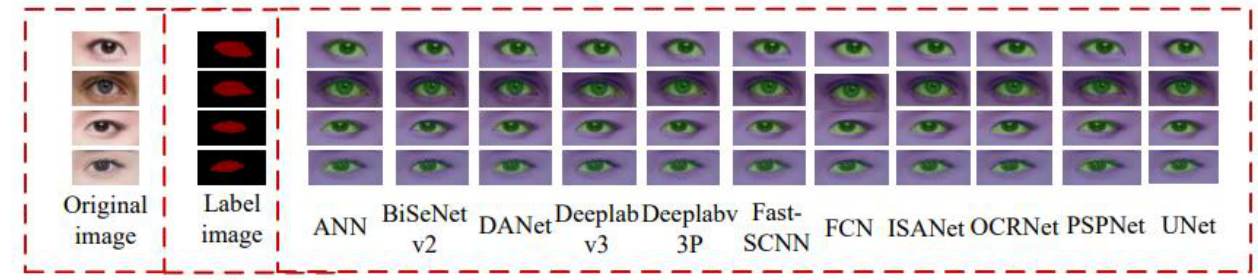
17 of 20 Table 3. Comparison of performance indicators of the 11 models on the right eye data. Method